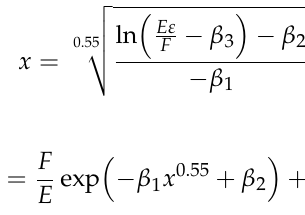
Figure 13. Stress with different toe notch radius under tensile load near weld toe.